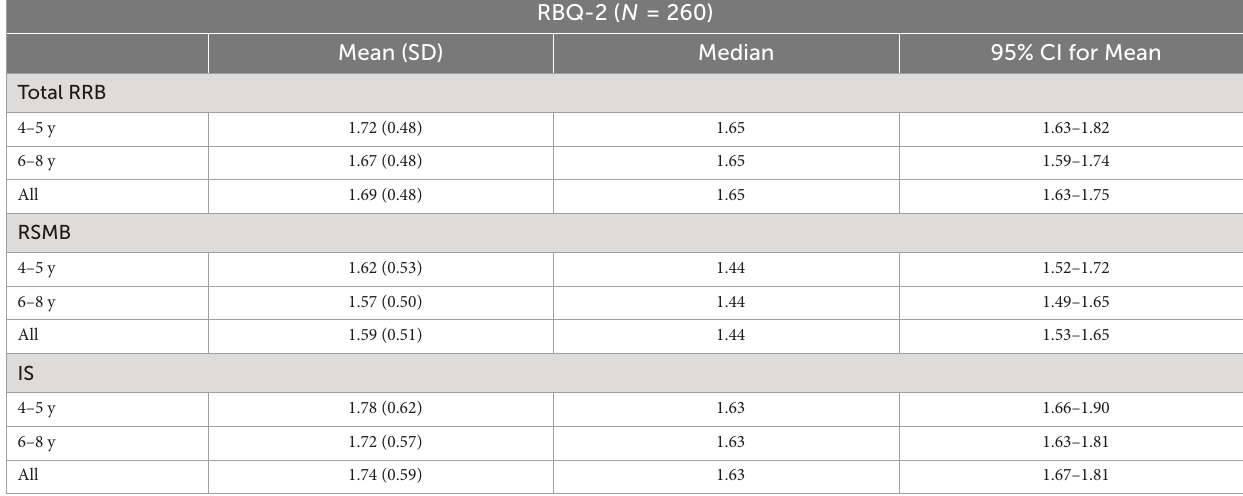
and the mean IS score for males was 1.81 (0.59) compared with 1.61 (0.57) for females. Mann Whitney tests found significant sex differences at p = 0.003 for RSMB and p = 0.007 for IS. As females ( M = 22.68, SD = 16.71) had higher anxiety scores than males ( M = 18.44, SD = 13.57; t (240) = − 2.131, p = 0.034) while males had higher RRB scores than females (see Figure 1 ), partial correlations were conducted to test for the association